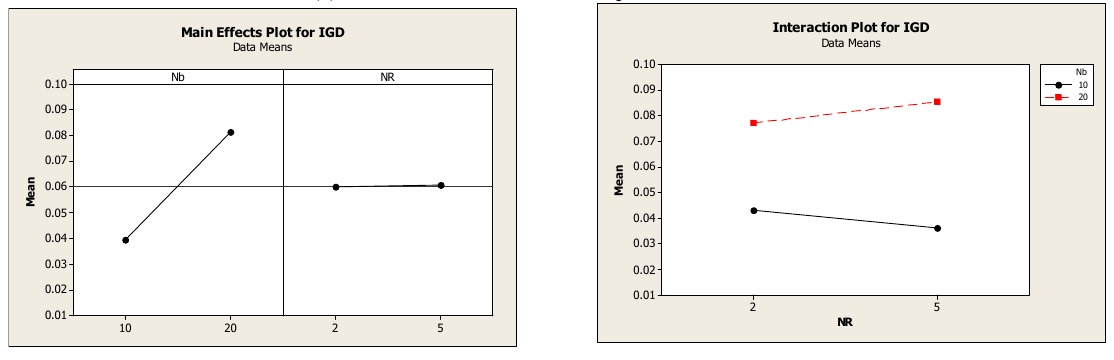
(a) Main effect and interaction plot for the 𝐺𝐷 metric